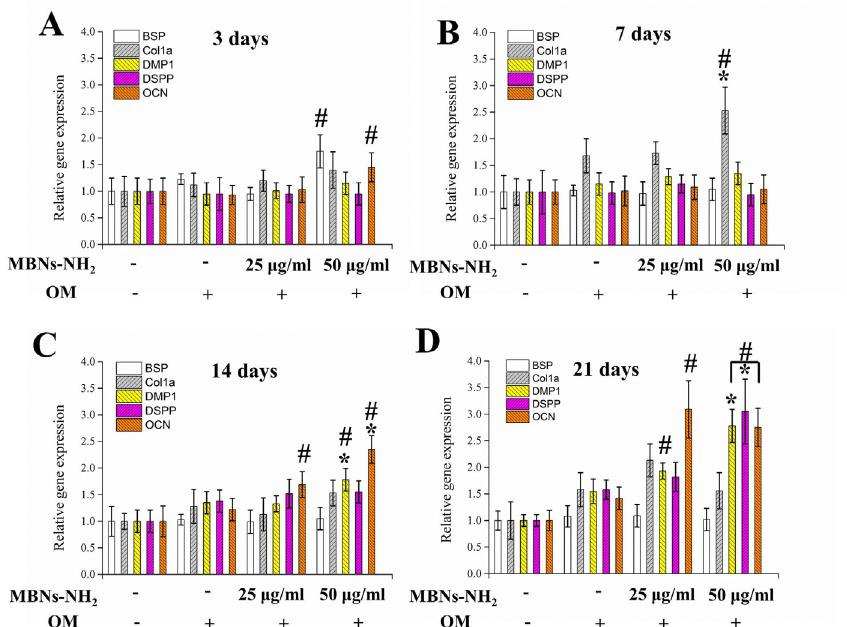
Fig 5. Effects of MBNs-NH 2 in rDPSCs on mRNA expression of odontoblasts at 3 days ( a ), 7 days ( b ), 14 days ( c ), and 21 days ( d ) of incubation with odontogenic supplemental medium (OM). # Statistically significant difference vs. OM group (p < 0.05). * Statistically significant difference between MBNs-NH 2 – treated groups (p < 0.05). The measurements were performed in triplicate, and representative average (n = 5) are shown with